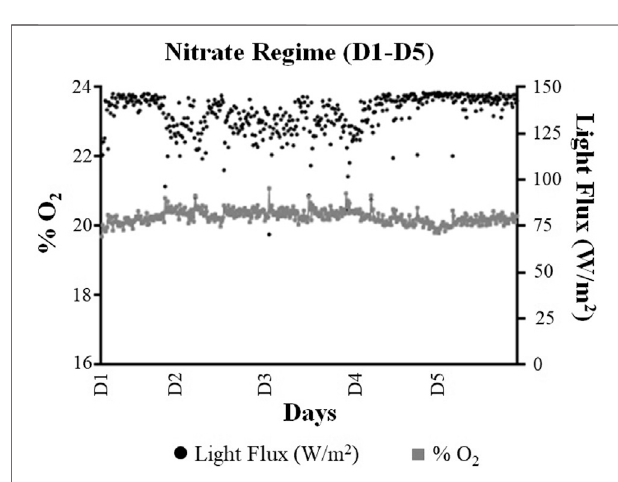
FIGURE 4 | Comparison of the average oxygen (% O 2 ) and light fl ux (W/m 2 ) values quanti fi ed using the monitoring system during the nitrate regime (Day 1 – Day 5). For the graphical representation of data, the values have been reported as the 15-min average of each analyte.